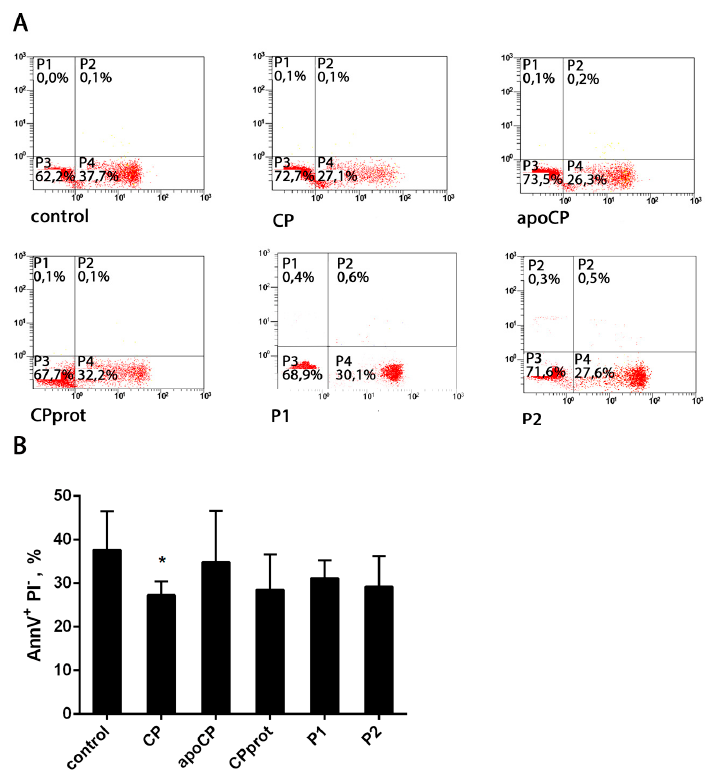
Figure 4. Spontaneous apoptosis of human neutrophils after exposure to ceruloplasmin (CP) or its derivatives. Polymorphonuclear leukocytes (PMNLs; 10 6 /mL) were cultured for 20 h at 37 °C without additives or with 0.5 µM intact CP, 0.5 µM apo-CP, 0.5 µM CPprot (proteolyzed CP), or 20 µM peptides (P1 or P2). The percentage of Annexin V- or propidium iodide (PI)-positive cells was determined by flow cytometry. ( A ) Representative dot plots for phosphatidylserine externalization